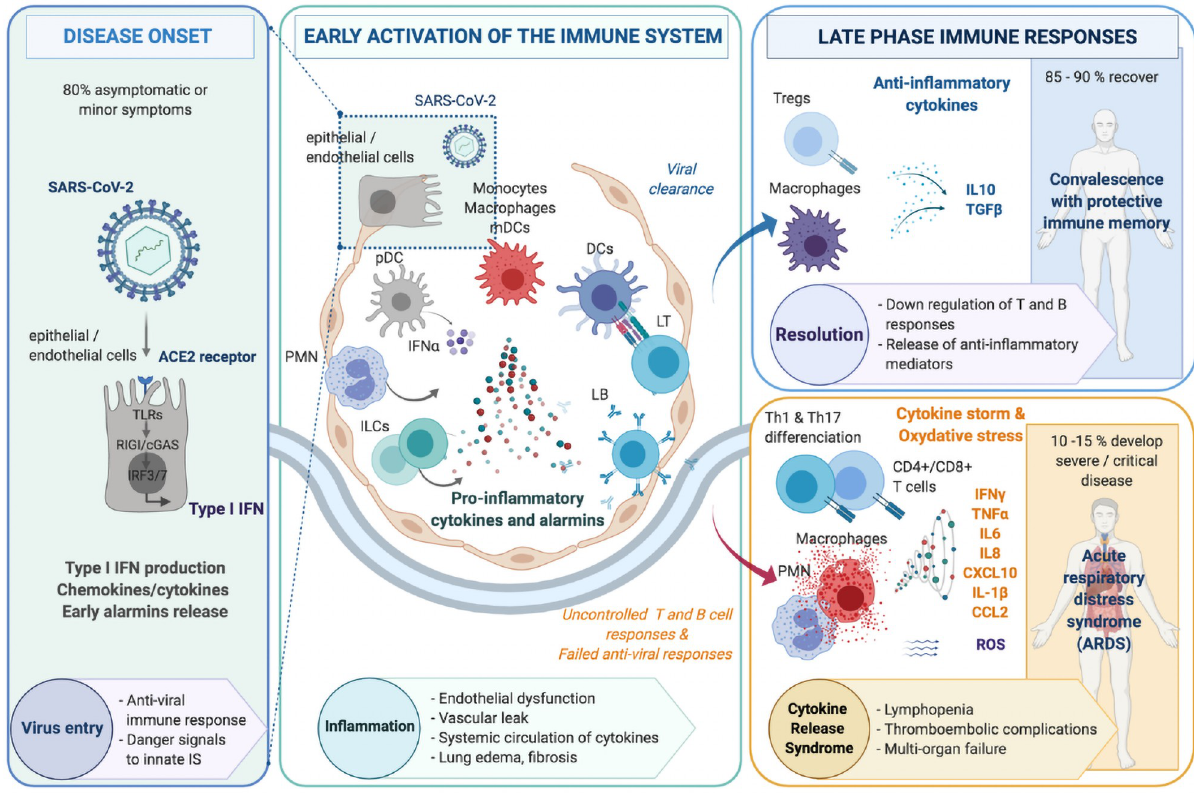
Fig 2. Three step progression towards severe COVID-19. The pathophysiology of COVID-19 in the airways encompasses schematically three successive steps, including (i) Disease onset following viral infection of alveolar epithelial or endothelial cells expressing the ACE2 receptor (left panel) leading to the activation of the innate immune system, with IFN α production by plasmacytoid dendritic cells (pDC). (ii) An early inflammatory phase within lung tissues where a cross-talk between infected epithelial/endothelial cells and innate immune cells such as monocytes, macrophages, myeloid dendritic cells (mDC) and innate lymphoid cells (ILCs) leads to a release of pro-inflammatory alarmins, cytokines and chemokines (center panel). This results in the activation of adaptive immunity, involving both CD4+ T cell help, CD8+ T cells cytotoxic for virally-infected cells as well as production of neutralizing antibodies against surface viral antigens. (iii) A late inflammatory phase with two potential outcomes: 85 to 90% of cases evolve towards resolution of inflammation with downregulation of T and B cell responses concomitant with the release of anti-inflammatory mediators (right upper panel); whereas 10 to 15% patients rather exhibit major tissue damage and severe acute respiratory distress syndrome (ARDS) caused by a deleterious uncontrolled inflammation linked with persisting T cell activation, excessive myeloid cell activation associated with a cytokine storm as well as oxidative stress (right lower